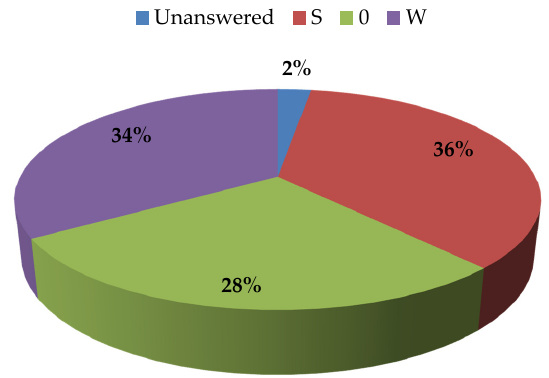
Figure 3. Percentage of students according to the differences shown in the valuation.